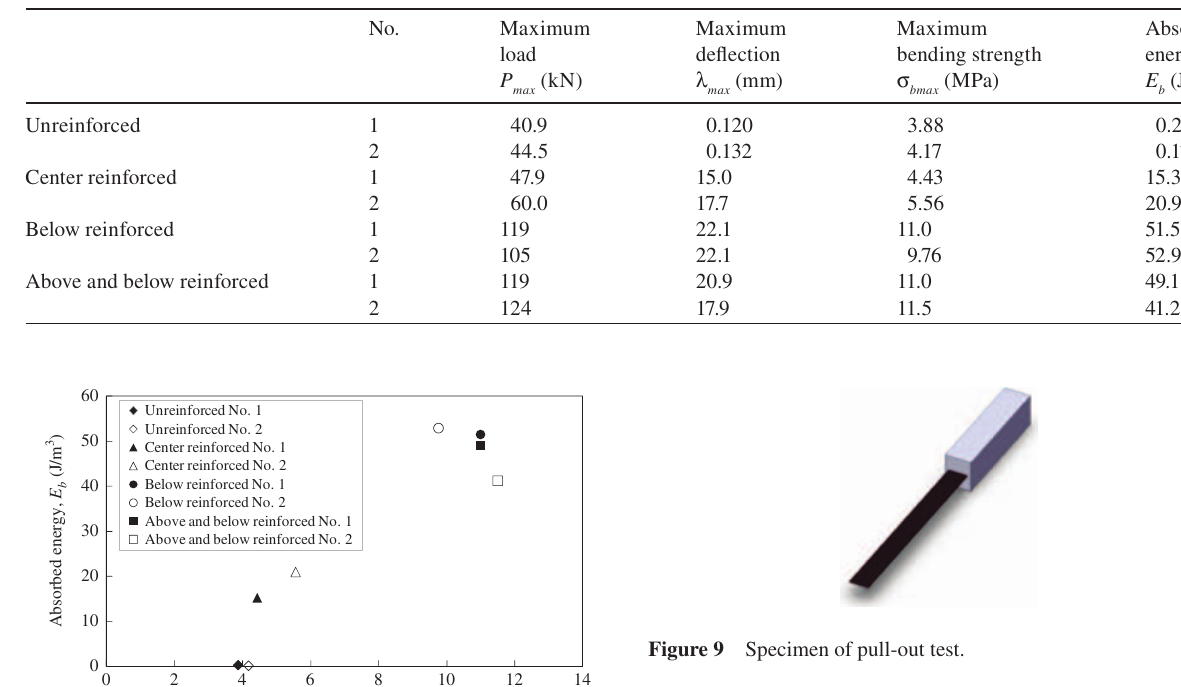
Table 1 Four points bending test results.